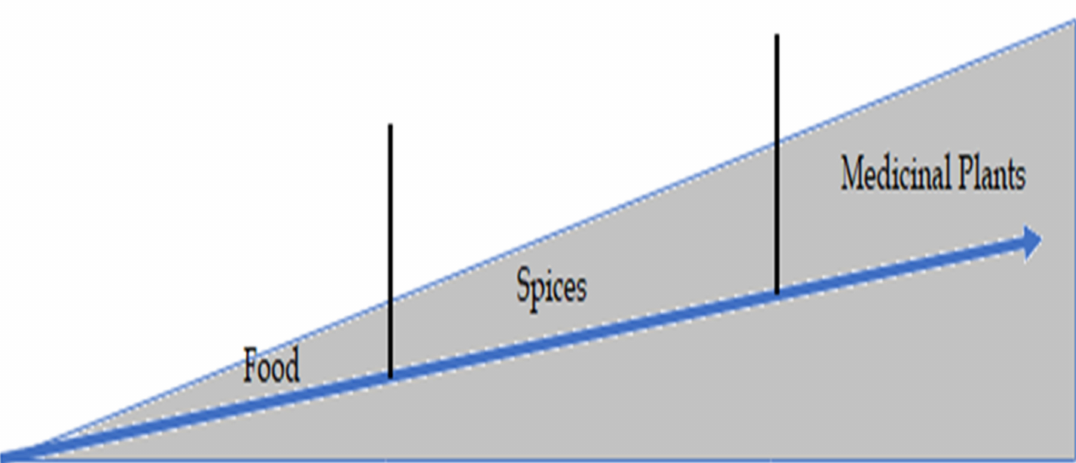
Figure 1. Conceptual diagram showing the comparative influence (on Y-axis) of food, spices, and medicinal plants (on X-axis) on the human body